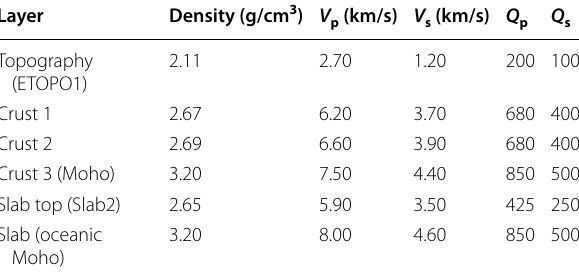
Table 1 Structure model used for the full